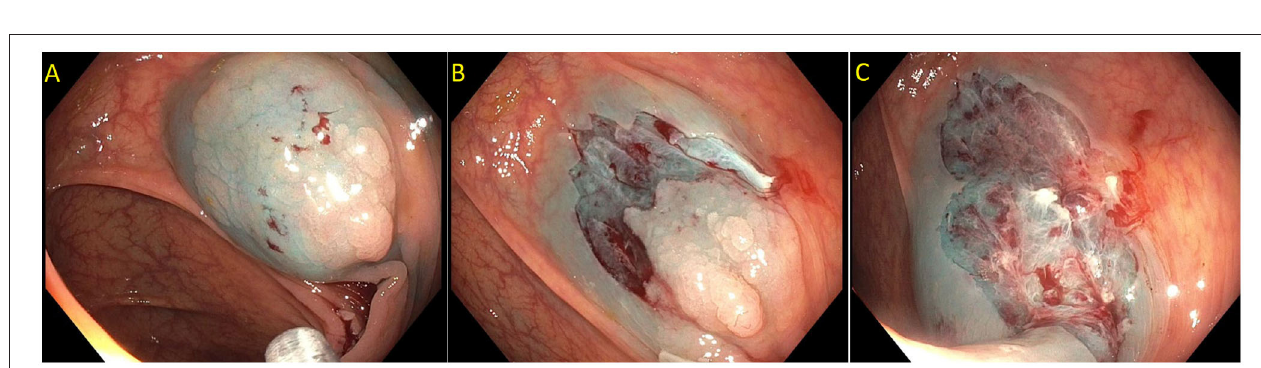
FIGURE 7 | (A) Sessile serrated lesion injected prior to resection to better define resection borders; (B,C) Sessile serrated lesion removed by dynamic submucosal injection and piecemeal cold endoscopic mucosal resection.